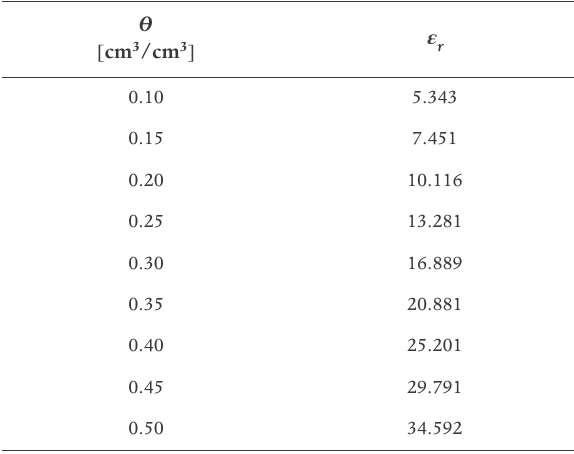
Table 3. Relative Permittivity and corresponding SWC values ac- cording to Topp